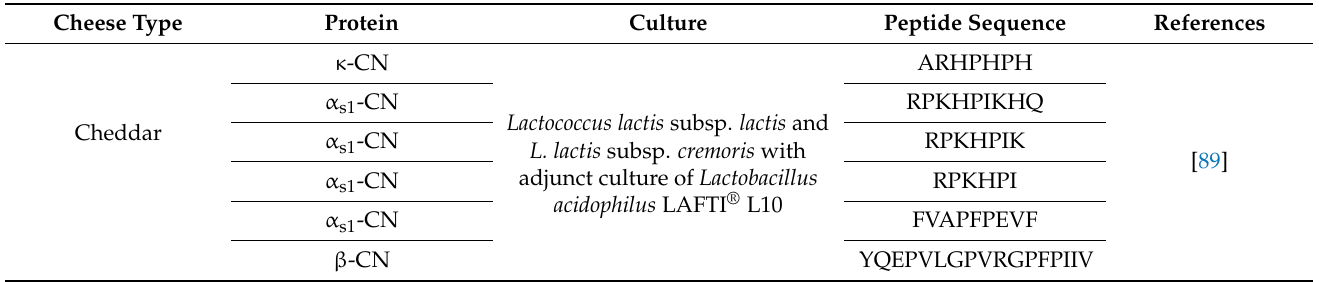
Table 3. Bioactive peptides with potential cardioprotective effects derived from